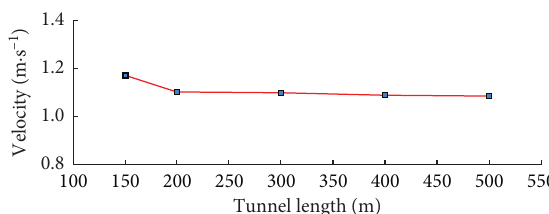
Figure 4: Flow velocity in the cross channel of tunnels with dif- ferent lengths of Scheme 1.